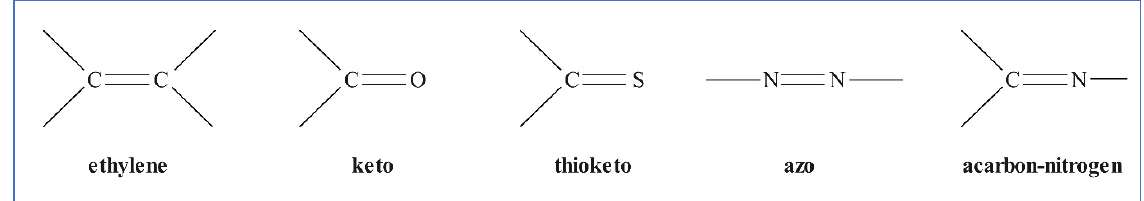
Figure 2. Color-producing chromophores or groups.